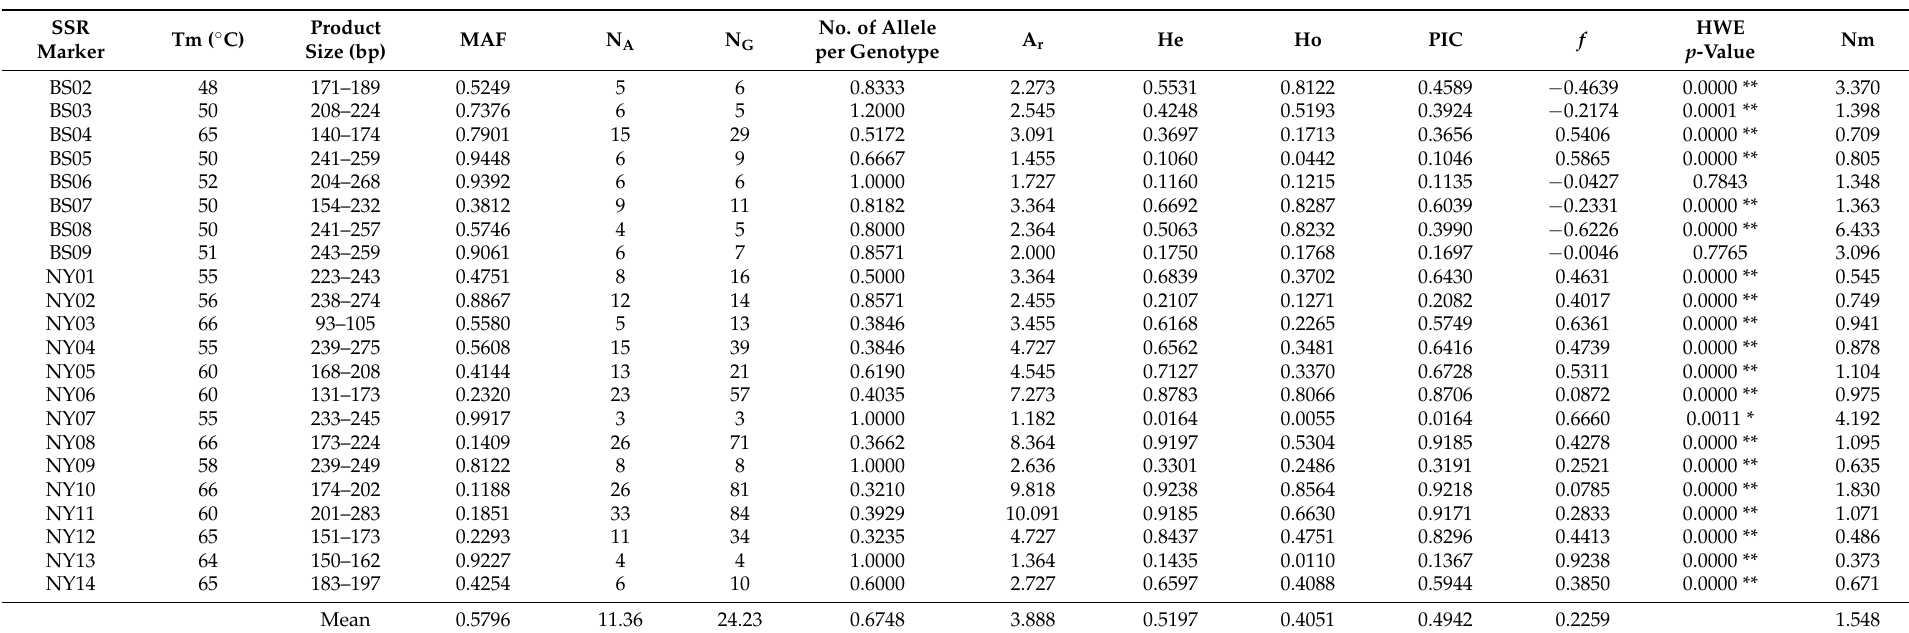
Table 3. Microsatellite diversity and polymorphism by locus with respective optimum Tm and product size